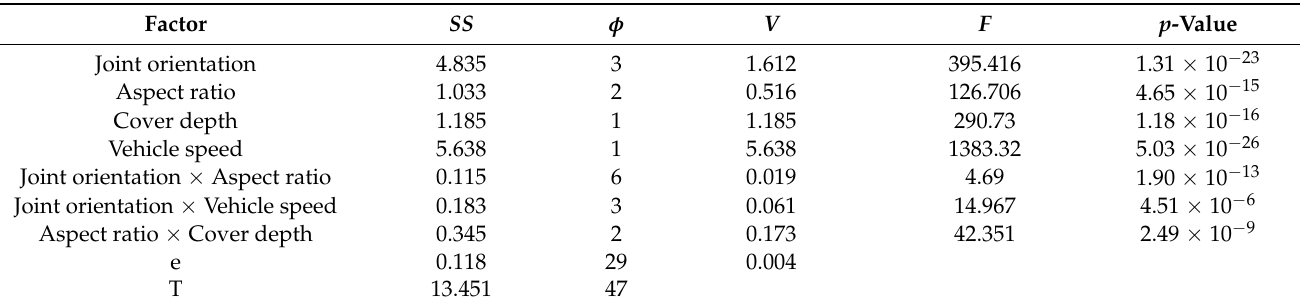
Table 10. ANOVA table after pooling non-significant